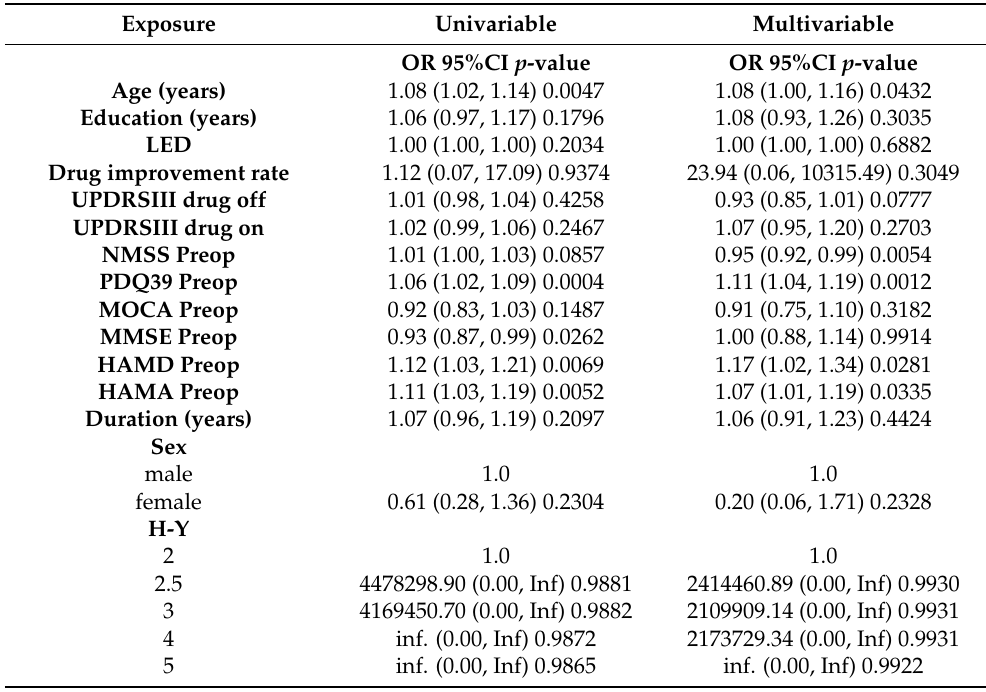
Table A2. Univariable and multivariate regression analysis showing the effect of the various factors on the improvement rate of depression.